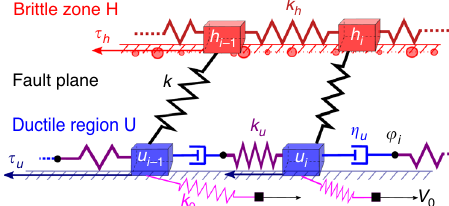
Fig. 1 The mechanical model. Mechanical sketch of the model (one- dimensional cut: the other direction is orthogonal to the plane). This is the direct extension of Fig. 1 from ref. 11 : each fault is modeled as a two- dimensional layer (and no longer as a single block). The fault plane H is subject to velocity-weakening friction τ h , in the form of randomly placed pinning points (red disks) with varying pinning strength τ th (disk radius). i The ductile region U is subject to velocity-strengthening friction τ u , and is pulled at constant velocity V 0 by distant regions. Within this ductile region, interactions are viscoelastic (Maxwell model), with dashpots having viscosity η u and elasticity k u . The relative elongations of dashpots around site i is denoted z i = φ i − u i − ( φ i − 1 − u i − 1 ). The two layers are connected elastically with a stiffness k